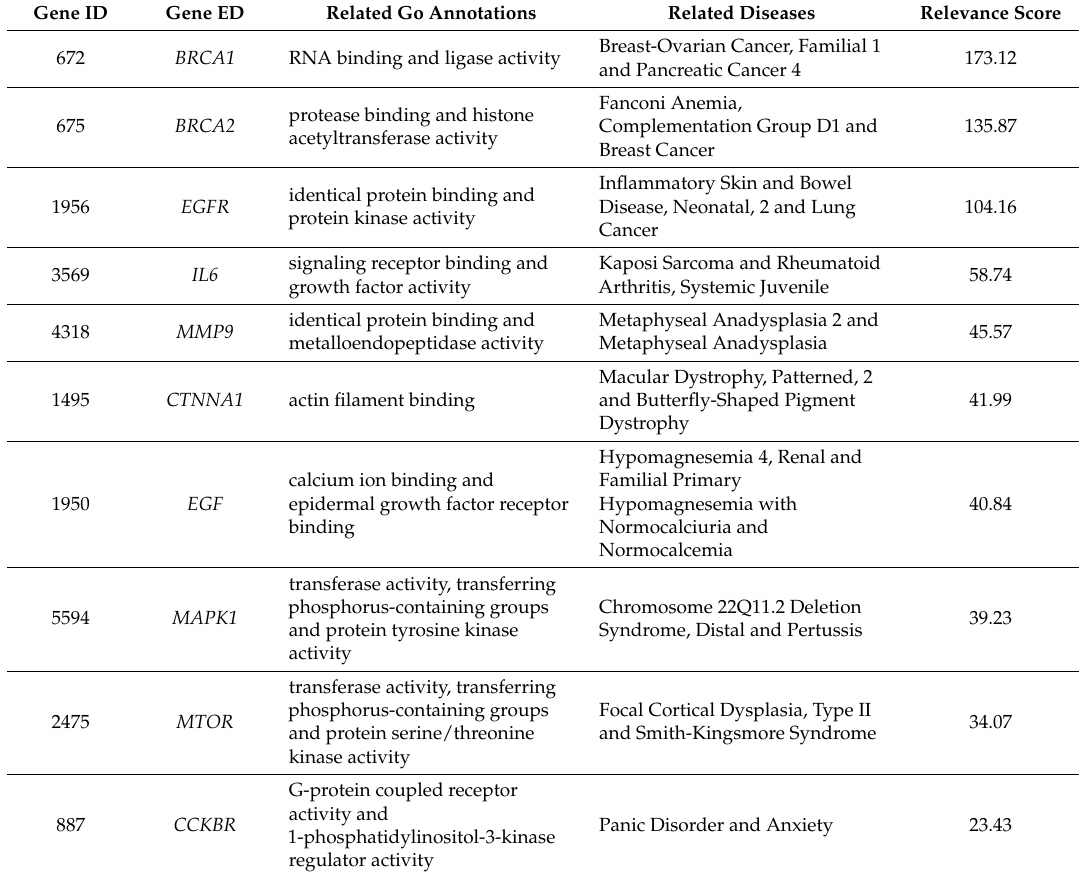
Table 5. Summary of the co-differential genes selected by the GMvNMF